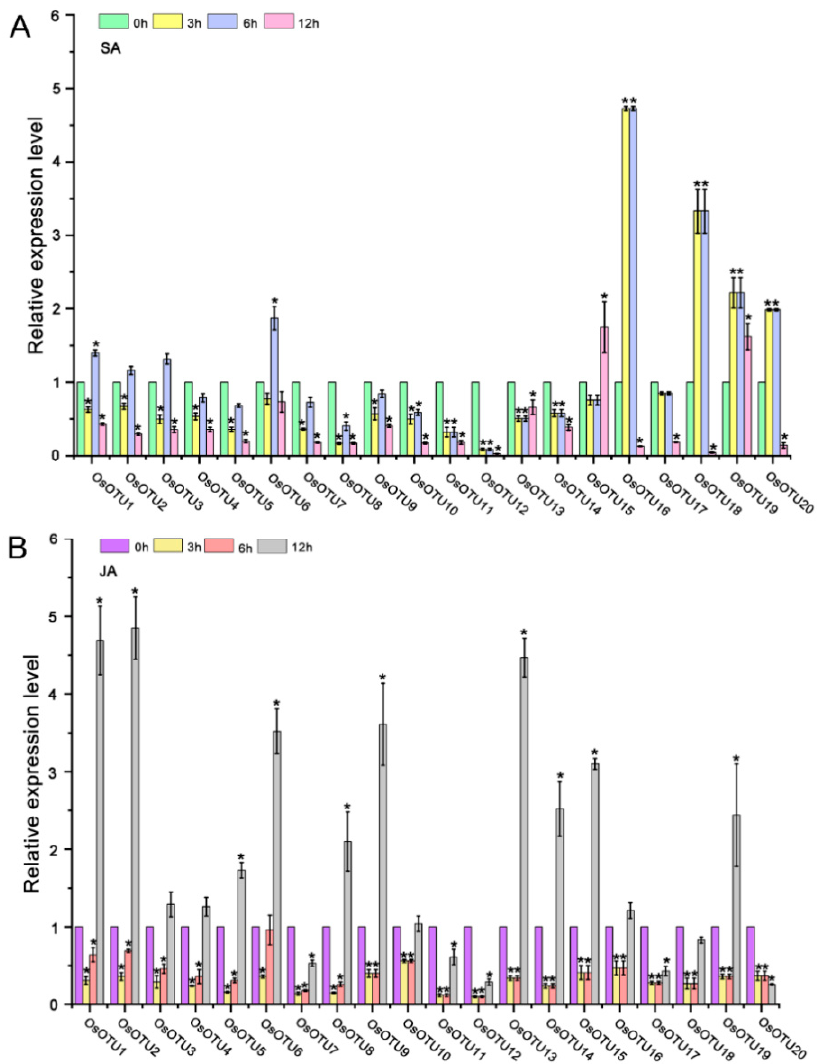
Figure 5. The expression pattern of OsOTU genes under different hormone treatments. Plants were treated with SA (500 µ M) ( A ), MeJA (100 µ M) ( B ). Samples were collected at 0, 3, 6, and 12 h. The OsUBQ5 gene was the reference gene used to calibrate the relative gene expression. Error bars represent ± SE ( n = 3). One-way analysis of variance was conducted by Duncan’s new multiple-range test, n = 3. * indicates significant differences from the mock control at p ≤ 0.05 by Fisher’s least significant difference tests.